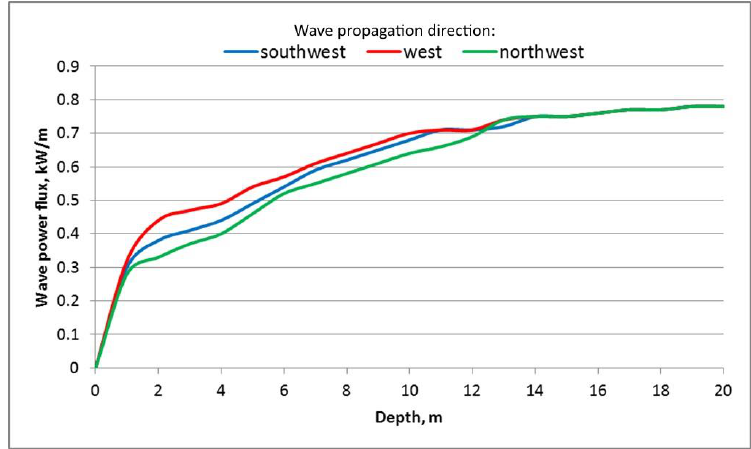
Figure 7. The impact of decreasing depth on wave power flux for a 0.67 m wave.